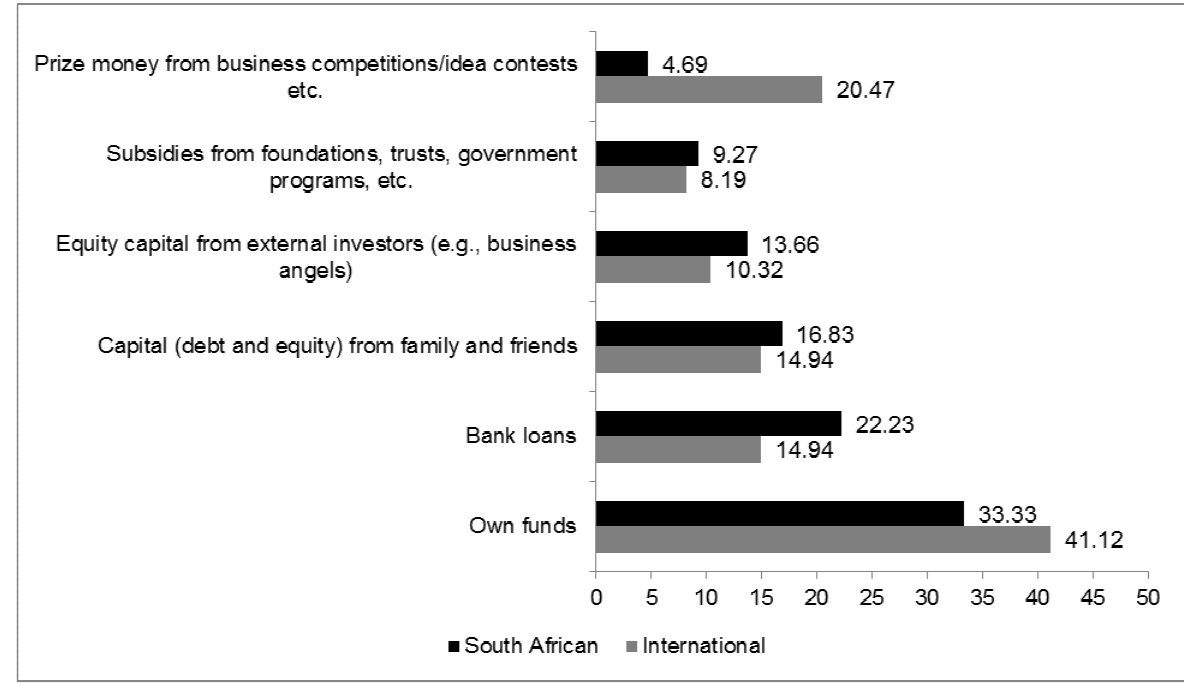
Figure 3: Planned sources of finance (in percentages) (Intentional founders South African N = 492; Intentional founders international N = 39